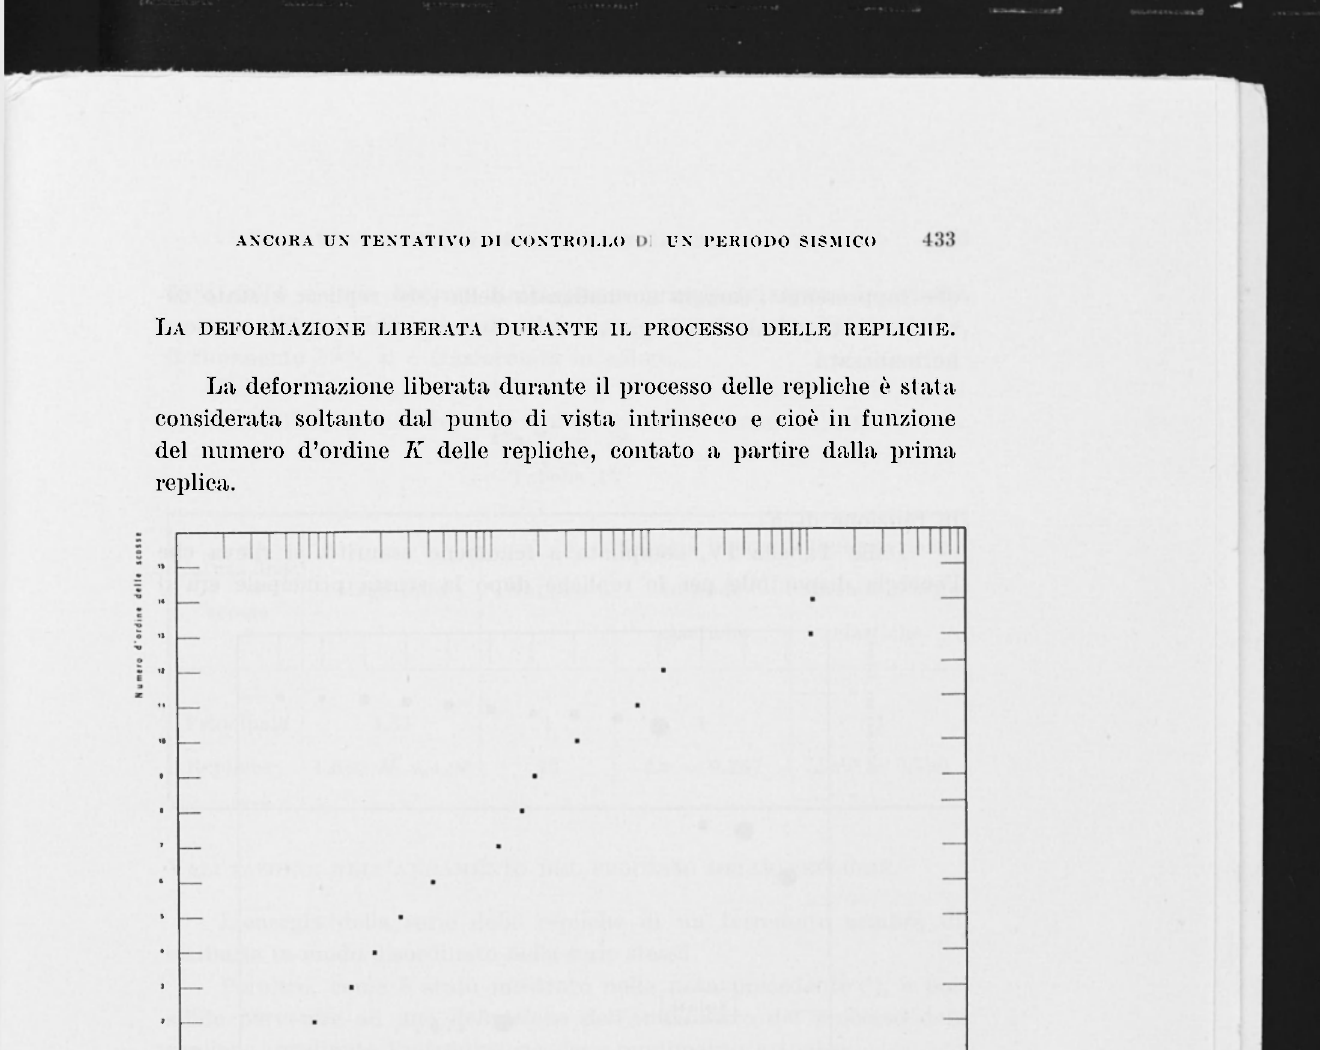
Fig. 2 - Numero d'ordine delle scosse in funzione del tempo.